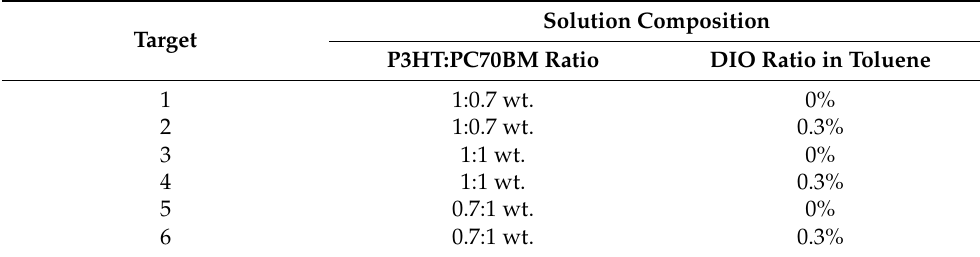
Table 1. Blend composition used in the fabrication of MAPLE targets for the active layer